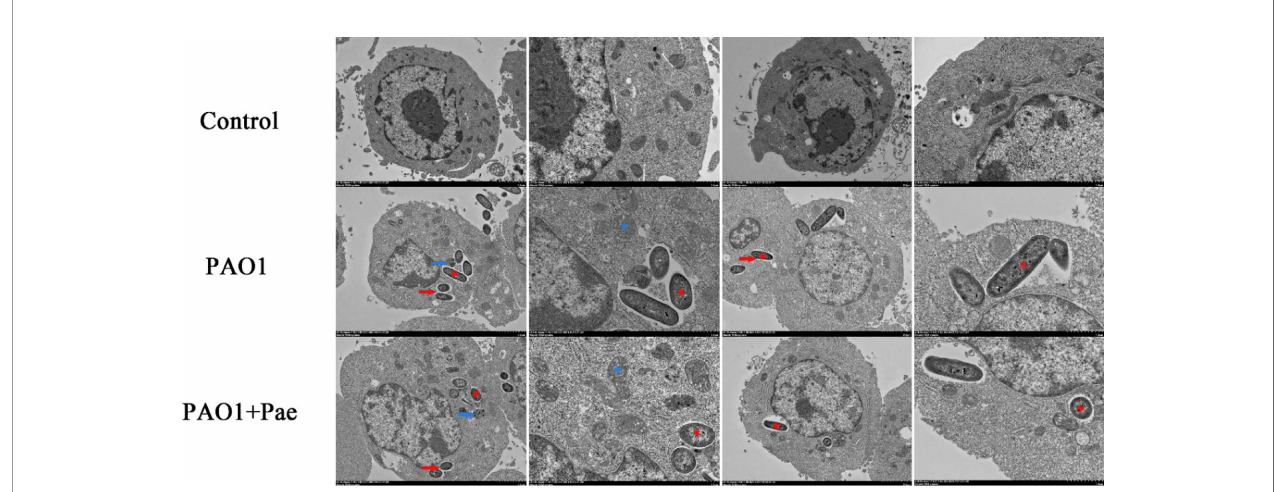
FIGURE 7 | Transmission electron microscope observation of paeonol on the ultrastructure of RAW264.7 macrophages infected with P. aeruginosa PAO1 (MOI=25:1). Scale bar, 2 m m (low magni fi cation in columns one and three) and 1 m m (high magni fi cation in columns two and four); red* indicates PAO1, blue* indicates mitochondria; red arrows indicate vesicles, blue arrows indicate